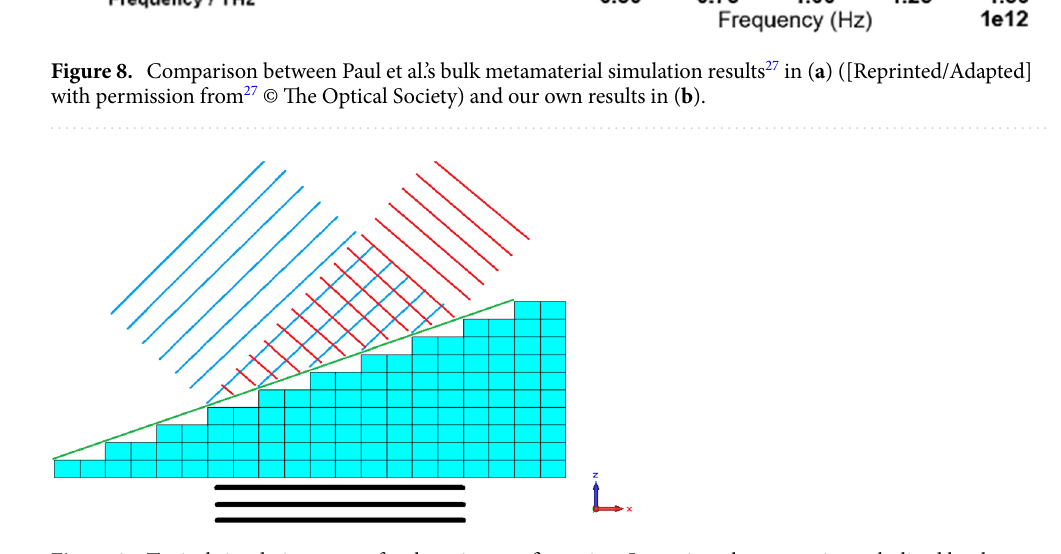
Figure 9. Typical simulation set-up for the prism configuration. Incoming plane wave is symbolized by the black lines. Positively refracted outgoing wave is symbolized by the red lines. The negatively refracted plane wave is symbolized by the blue lines. The green line delineates the idealized upper